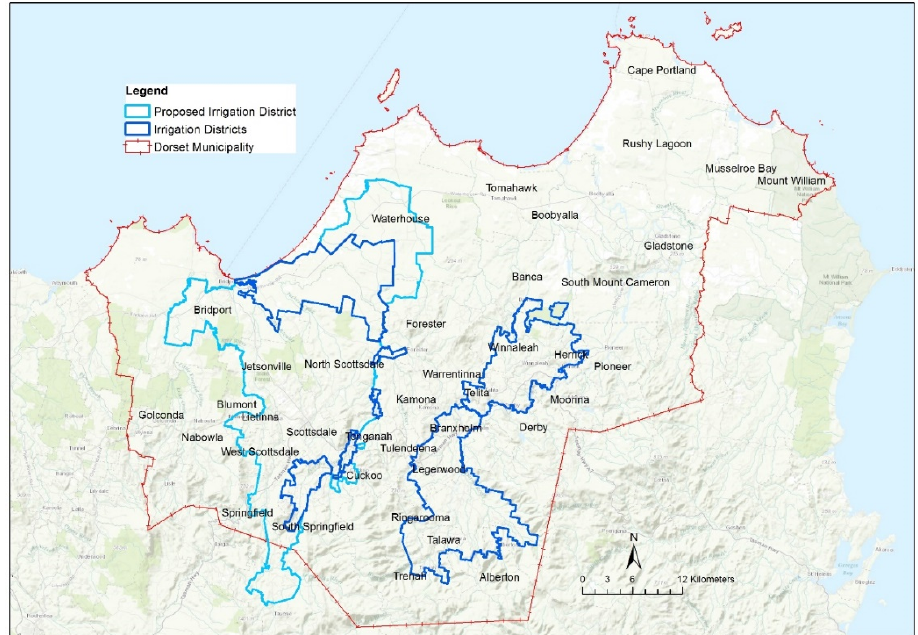
Figure A1. Current and proposed irrigation districts in the Dorset region of north-eastern Tasmania, Australia (DPIPWE 2019). Both current and proposed districts are used for model